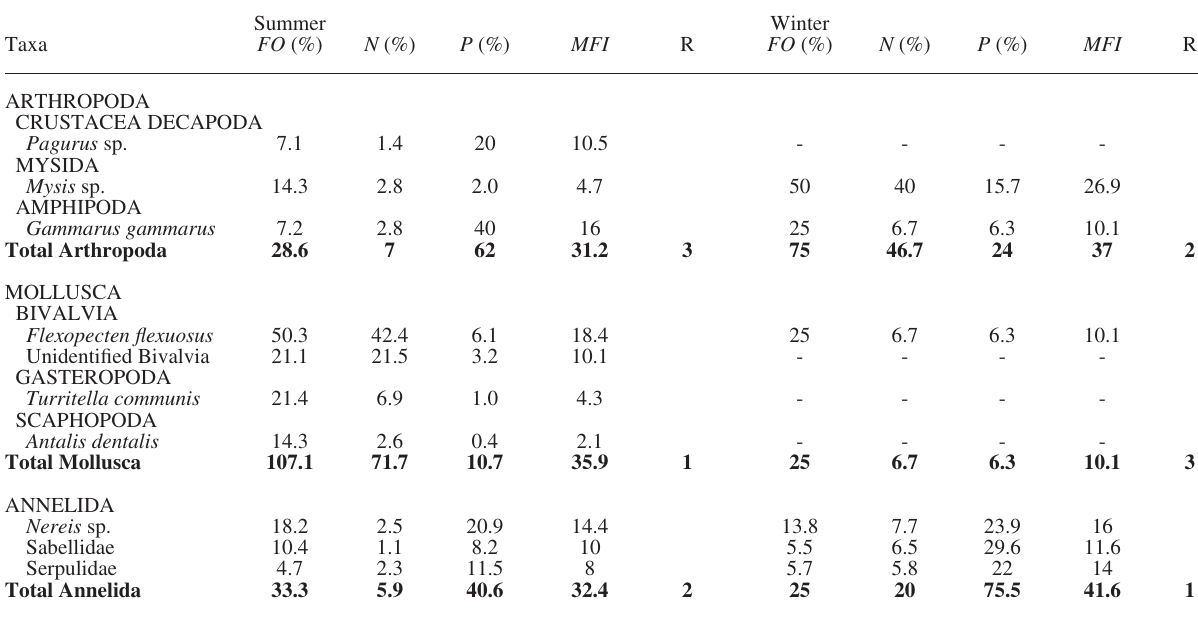
Table 10. – Prey identified in the stomach contents of P. acarne juveniles in relation to season. FO , frequency of occurrence; N , numerical percentage; P , point percentage; MFI , main food index; R, classification of prey. summer Winter taxa aRthRoPoda CRustaCea deCaPoda Pagurus sp. Mysis sp. gammarus